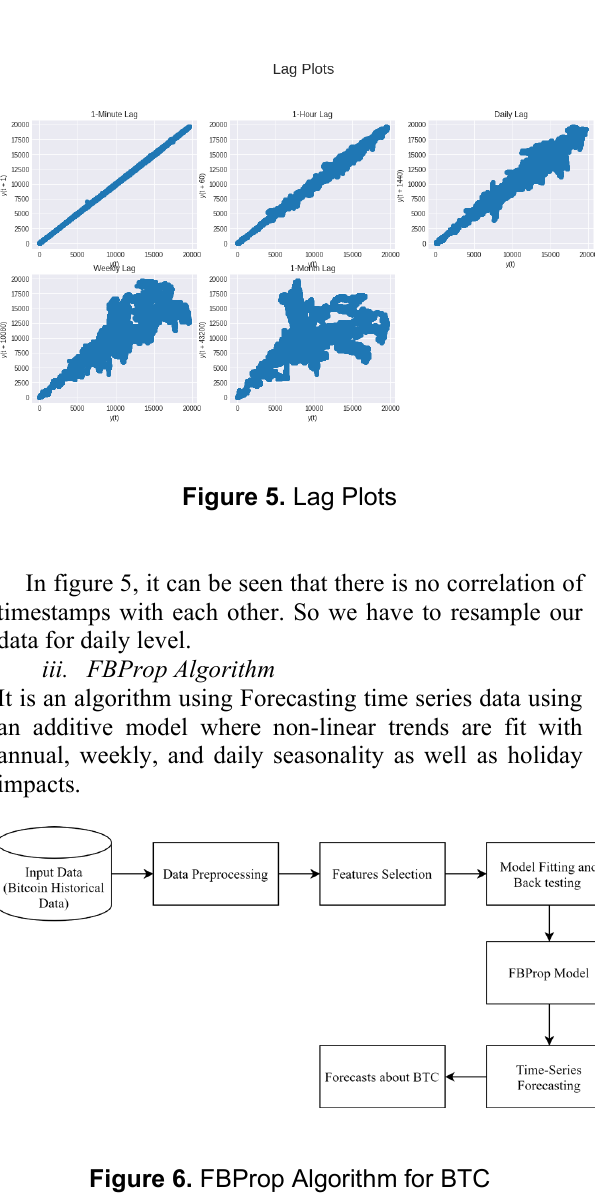
Figure 6. FBProp Algorithm for